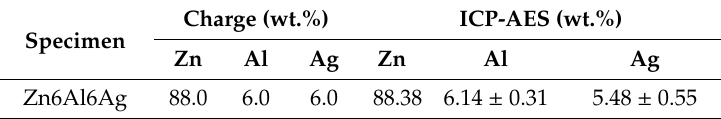
Table 1. Composition of Zn–Al–Ag alloys and the results of chemical analysis done using